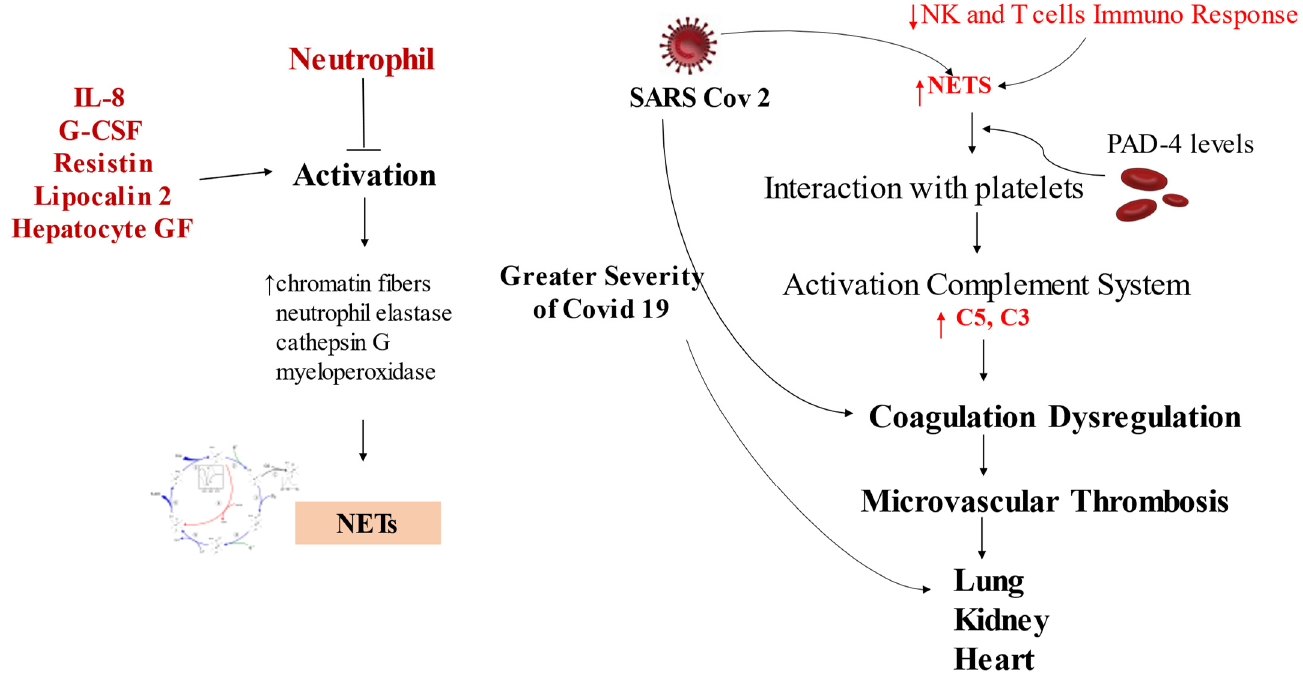
Figure 2. SARS-CoV-2 causes activation of neutrophils mediated by IL-8, G-CSF, resistin, lipocalin-2, hepatocyte growth factor and NET release. The immune response of NK and T lymphocytes con- tributes to the formation of NETs with the activation of the complement system (C5 and C3). The result is the development of microvascular thrombosis, which leads to organ damage. Abbreviations: C, complement; GF, growth factor; IL, interleukin; NK, natural killer cells. Other abbreviations are provided in the text. Arrows explain the increase or decrease of relative component